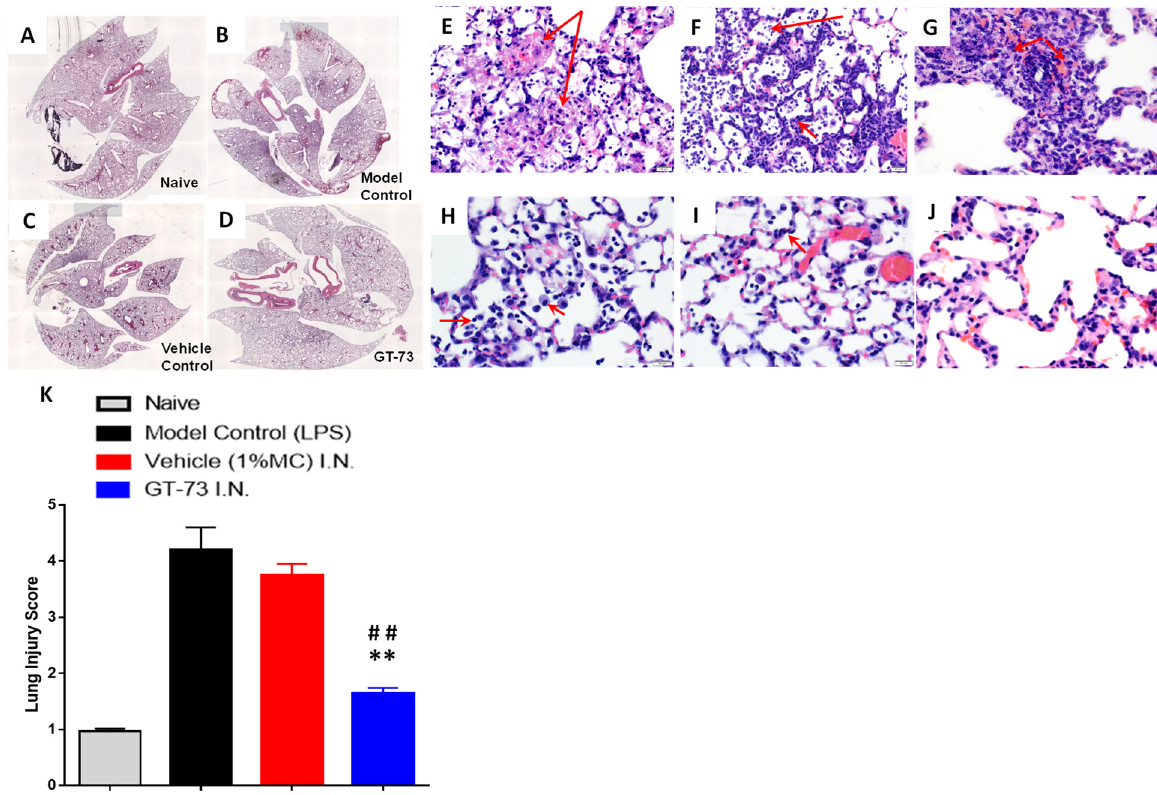
Figure 3. Histological evaluation of the lung inflammation level. Slides were prepared and processed as described in Figure 2. Images of whole-mount lungs were taken at low magnification (×20): ( A ) naive mice; ( B ) untreated model control (LPS); ( C ) vehicle-treated lungs; ( D ) GT-73-treated lungs. Images were taken at high magnification (×400). Upper panel, vehicle-treated lungs: ( E ) fibrin deposits; ( F ) septal and alveolar neutrophils infiltration. ( G ) neutrophilic debris deposits. Lower panel, GT-73-treated lungs: ( H ) alveolar neutrophil infiltration and foaming macrophages; ( I ) septal neutrophil infiltration. ( J ) normal lungs (naïve); ( K ) Lung injury histological score, n = 7, mean ± SD, significant difference between treated by GT-73 and the vehicle groups, ## p ≤ 0.003. Significant difference between treated by GT-73 and the model control groups ** p ≤ 0.003.